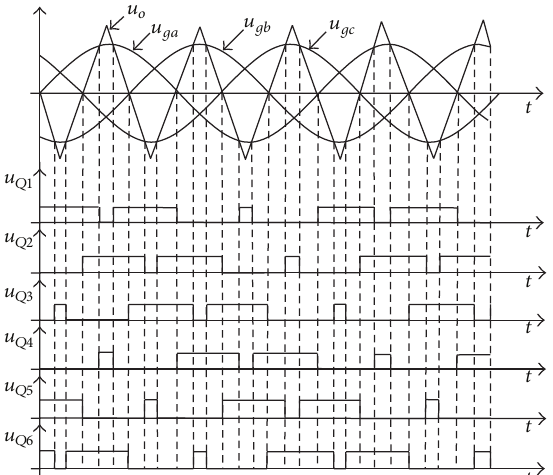
Figure 2: The three-phase SPWM control